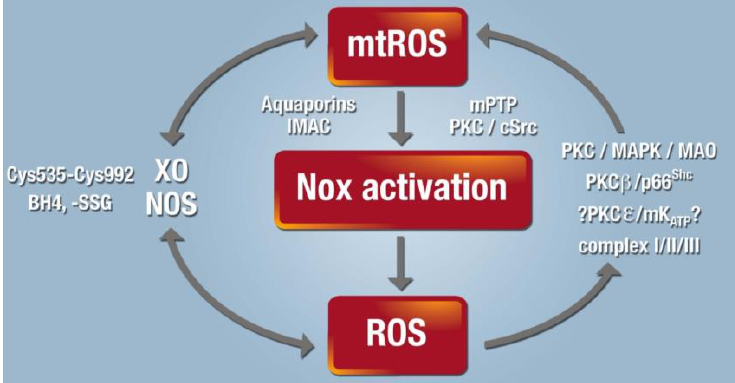
Figure 4. Cross talk between di ff erent sources of RONS (mitochondria, NOX, XO, and uncoupled NOS). XO originates from oxidative stress-mediated conversion of the xanthine dehydrogenase via oxidation of critical thiols in cysteine535 / 992 [143,144]. NOS (mainly eNOS) are uncoupled upon oxidative depletion of BH4 [129], S -glutathionylation (-SSG) [145], adverse phosphorylation by PKC [146] or protein tyrosine kinase-2 [147], and other redox switches (reviewed in [90]). Mitochondrial O 2 • ¯ / H 2 O 2 formation is triggered by oxidative stress from all ROS sources (including other damaged / activated mitochondria) via redox-activation of PKC, mitogen-activated protein kinases (MAPK), other kinase pathways, and potential involvement of redox-sensitive mtK ATP with subsequent p66 Shc , MAO, respiratory complex activation, or impairment of mitochondrial antioxidant defense (reviewed in [127]). Mitochondrial O 2 • ¯ / H 2 O 2 is released to the cytosol via mitochondrial pores and channels (e.g., redox-sensitive mPTP, inner membrane anion channel (IMAC) or aquaporins) or by di ff usion due to increased mitochondrial permeability under pro-inflammatory conditions (reviewed in [127]). In the cytosol, these species (along with released calcium) cause activation of redox-sensitive PKC and tyrosine kinases (cSrc) with subsequent activation of NOX and amplification of the cellular oxidative stress [139]. Adapted from [127] with permission.